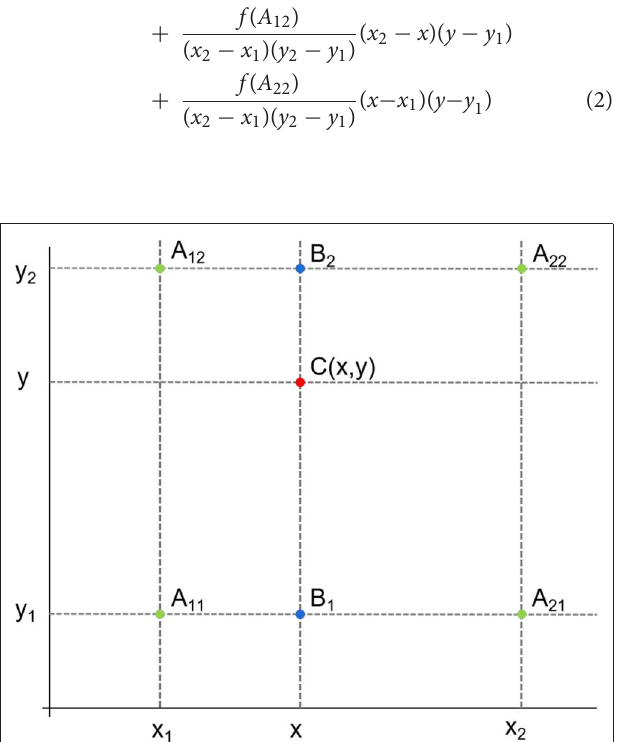
FIGURE 10 | Bilinear feature interpolation.